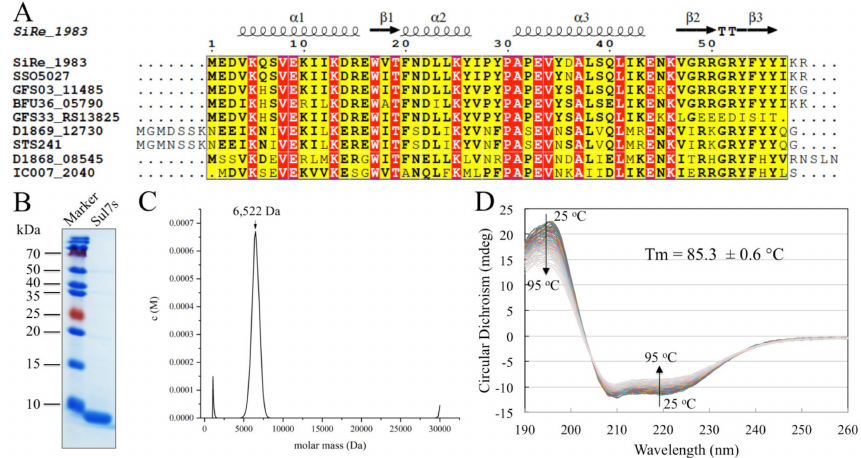
Figure 1. Characterization of the recombinant Sul7s protein. ( A ) Sequence alignment of Sul7s family proteins. Sequences are from S. islandicus (SiRe_1983), Saccharolobus solfataricus (SSO5027), Sulfolobus sp. E5-1-F (GFS03_11485), Sulfolobus sp. A20 (BFU36_05790), Stygiolobus azoricus (D1868_08545), Sulfuracidifex tepidarius (IC007_2040), Sulfurisphaera ohwakuensis (D1869_12730), Sulfurisphaera tokodaii (STS241) and Sulfolobus sp. E11-6 (GFS33_RS13825). ( B ) SDS-PAGE analysis of the recombinant Sul7s protein purified from E. coli . ( C ) Analytical ultracentrifugation of the recombinant Sul7s protein. The calculated apparent molecular mass of Sul7s is indicated. ( D ) CD spectra of Sul7s at temperatures ranging from 25–95 ◦